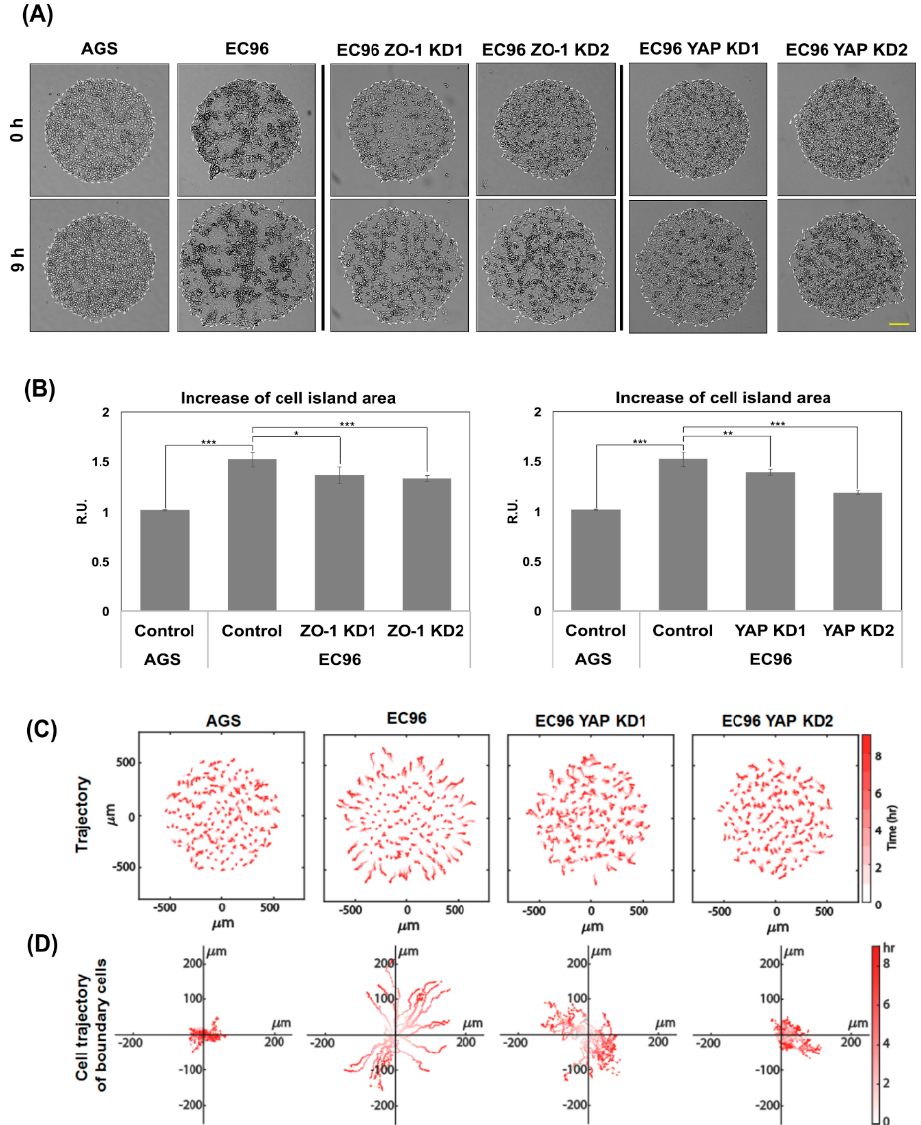
Figure 6. YAP participated in straightforward cell migration of EC96. ( A ) AGS, EC96, EC96 ZO-1 KD, and YAP KD cells were subjected to cell island expansion analysis. EC96 YAP KD cells were established by introducing YAP shRNA to EC96 cells. Bright-field images of cell islands at 0 h and 9 h are shown. Scale bar = 200 µ m. ( B ) Quantification of cell island expansion; means of triplicate experiments. * p < 0.05, ** p < 0.01 and *** p < 0.001. ( C ) Trajectory of cells in AGS, EC96, and EC96 YAP KD cell islands. Red color intensity indicates time elapsed. ( D ) Trajectories from the initial locations of boundary cells in AGS, EC96, and EC96 YAP KD cell islands. Red color intensity indicates time